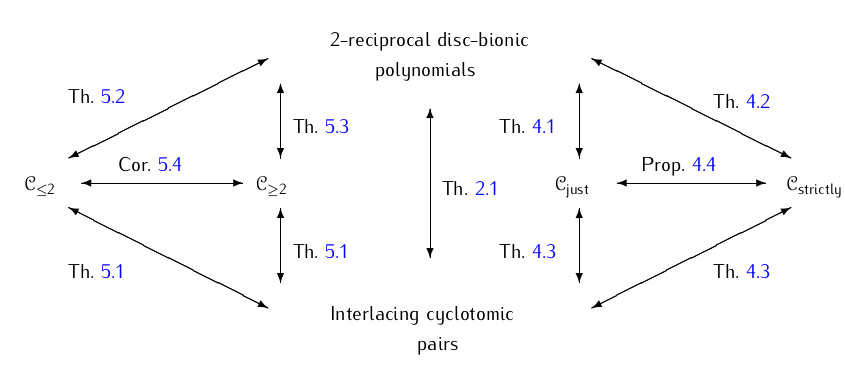
Figure 1. Various